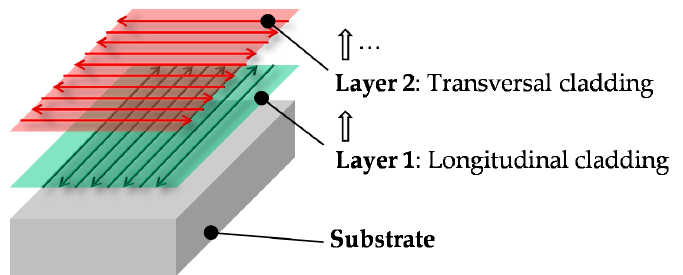
Figure 3. Deposition strategy of AISI H13.